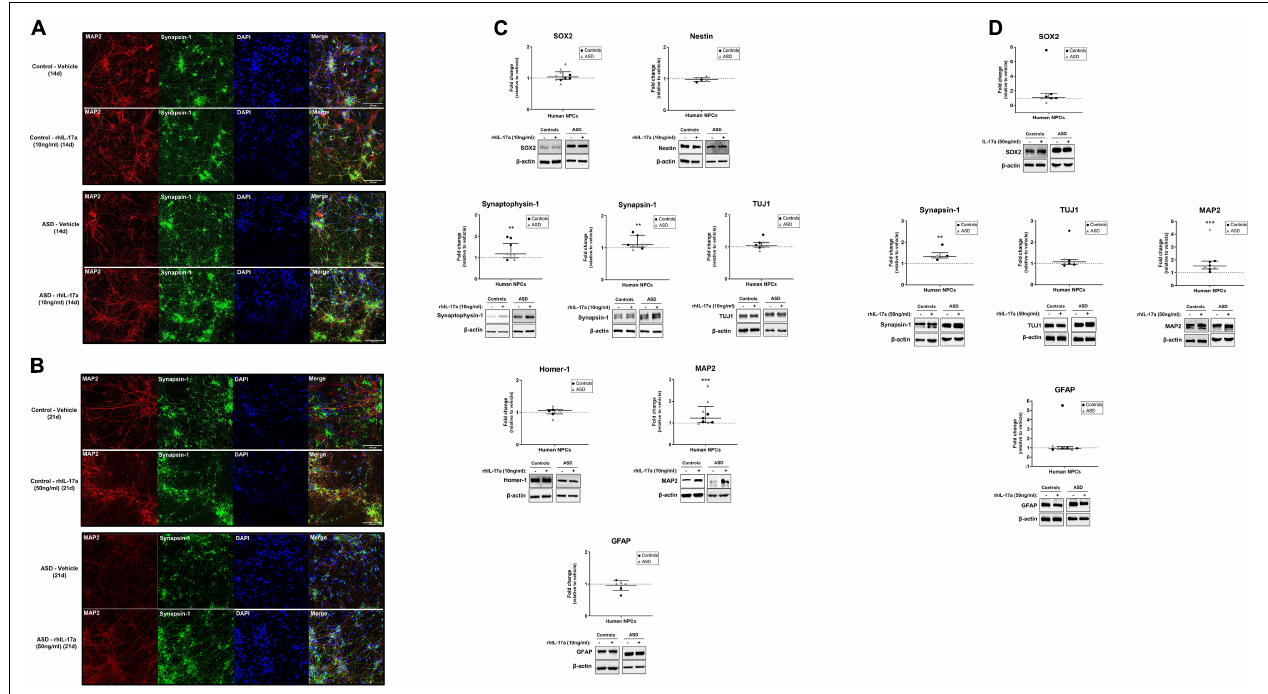
FIGURE 3 | Exogenous IL-17a stimulates neuronal differentiation of human NPCs. (A,B) Representative images (20 × objective) of qualitative immunocytochemistry staining of iPSC-derived neurons of control and ASD subjects differentiated in the presence of either vehicle or rhIL-17a (10 or 50 ng/ml) for either 14 or 21 day showing the expression of the synaptic protein Synapsin-1 and the cytoskeleton protein MAP2. Nuclei were stained with DAPI (blue). Control- and ASD-derived neurons show characteristic neuronal morphology, and no gross differences were observed between the control and ASD groups. (C) Relative protein levels of markers for NPCs (SOX2 and Nestin), neurons (Synaptophysin-1, Synapsin-1, TUJ1, Homer-1 and MAP2) and astrocytes (GFAP) in iPSC-derived neurons of control ( n = 3–4) and ASD ( n = 3–6) subjects differentiated in the presence of either vehicle (–) or rhIL-17a (10 ng/ml) for 14 day. β -actin was used as a loading control and the data are expressed as fold change in normalized protein expression relative to vehicle-treated samples. Representative immunoblot images are shown. (D) Relative protein levels of markers for NPCs (SOX2), neurons (Synapsin-1, TUJ1, and MAP2) and astrocytes (GFAP) in iPSC-derived neurons of control ( n = 3–5) and ASD ( n = 3) subjects differentiated in the presence of either vehicle (–) or rhIL-17a (50 ng/ml) for 21 day. β -actin was used as a loading control and the data are expressed as fold change in normalized protein expression relative to vehicle-treated samples. Representative immunoblot images are shown. While no significant differences were found in the expression levels of NPC and astrocyte markers between rhIL-17a-treated and untreated cells, significantly increased levels of several neuron markers were observed in rhIL-17a-treated human NPCs. ** p ≤ 0.01, *** p ≤